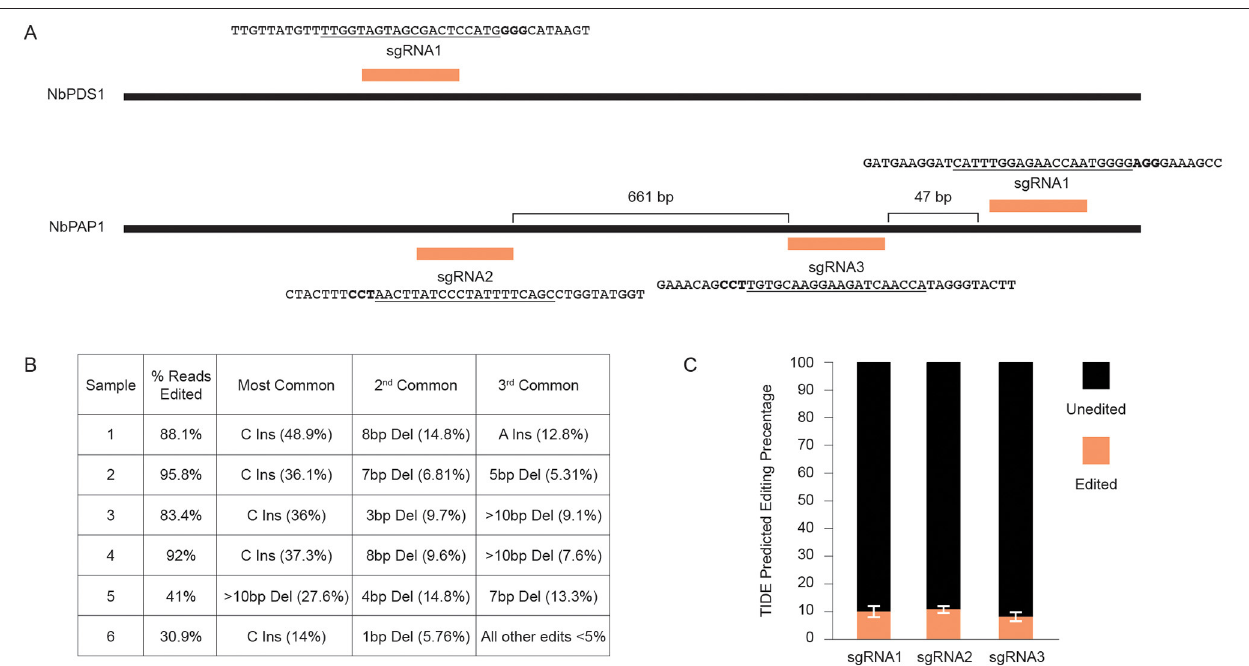
FIGURE 4 | Using fast-TrACC to determine gene editing efficiencies at distinct target sites in N. benthamiana . (A) Fast-TrACC was used to test a previously characterized sgRNA that targets NbPDS1 in N. benthamiana as well as three untested sgRNAs targeting the N. benthamiana locus, NbPAP1 . The sequences targeted by the sgRNAs are underlined and the PAM sequence is in bold. (B) DNA was prepared from six seedlings treated with reagents targeting NbPDS1; gene editing frequencies at NbPDS1 were quantified by NGS. High frequency gene editing was observed in each sample, where editing efficiency is the percentage of total sequencing reads with a gene edit. (C) The frequency of editing for the three tested NbPAP1 sgRNAs was substantially lower than the previously characterized NbPDS1 sgRNA. sgRNA1 = 10.28% ± 2.18%; sgRNA2 = 11.12% ± 1.47; sgRNA3 = 8.38% ±